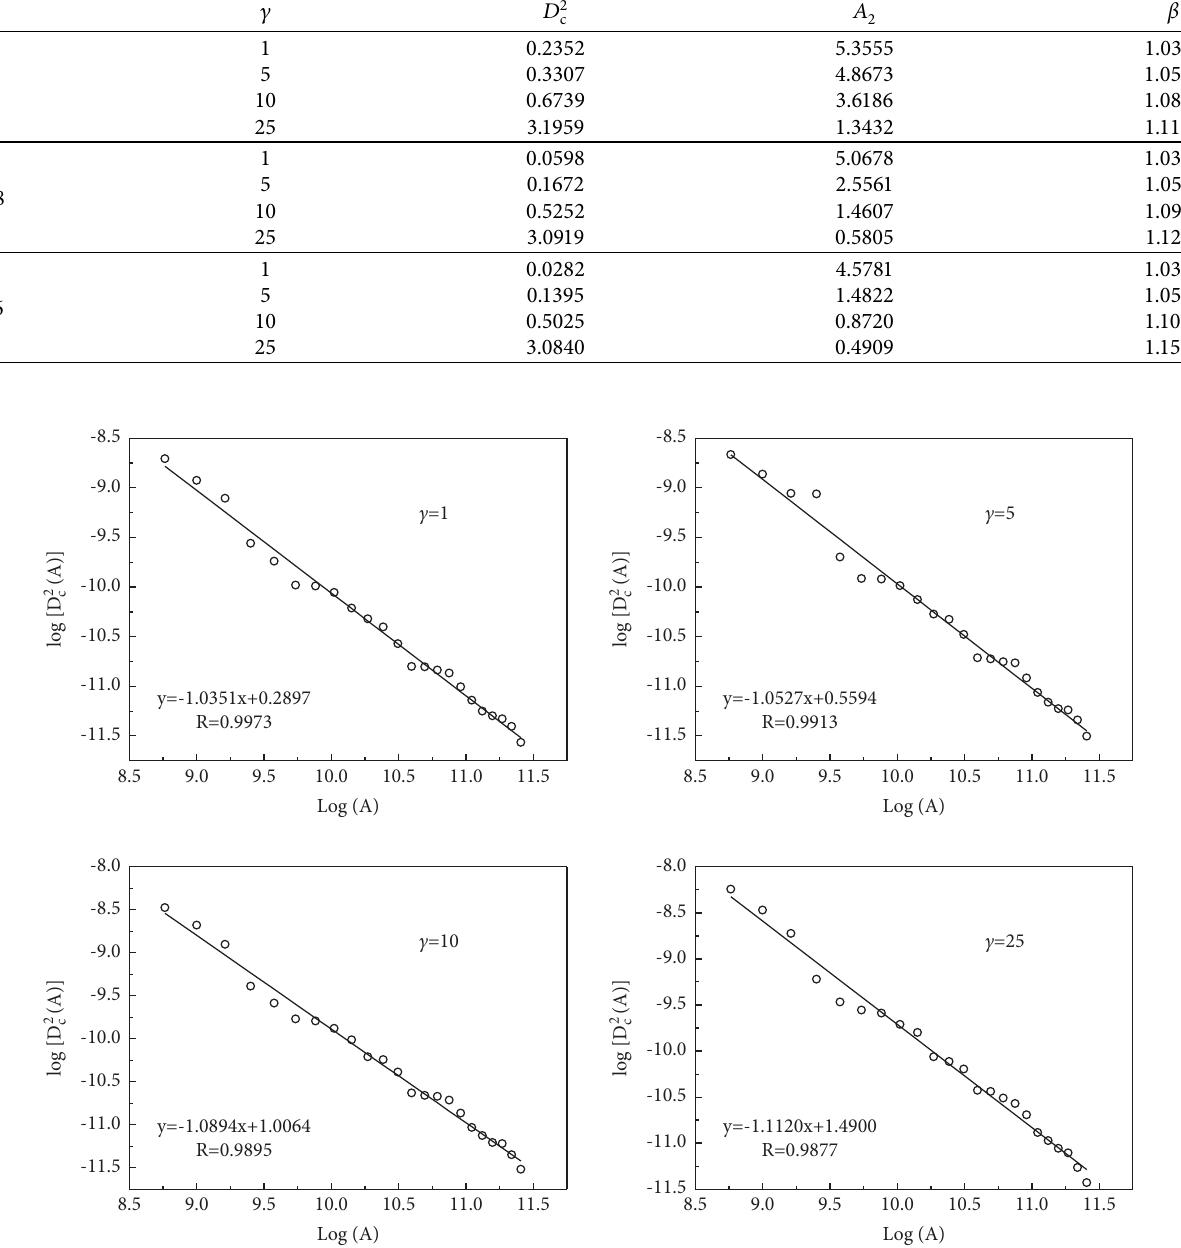
Table 1: Parameter ftting results for diferent k values and c values.